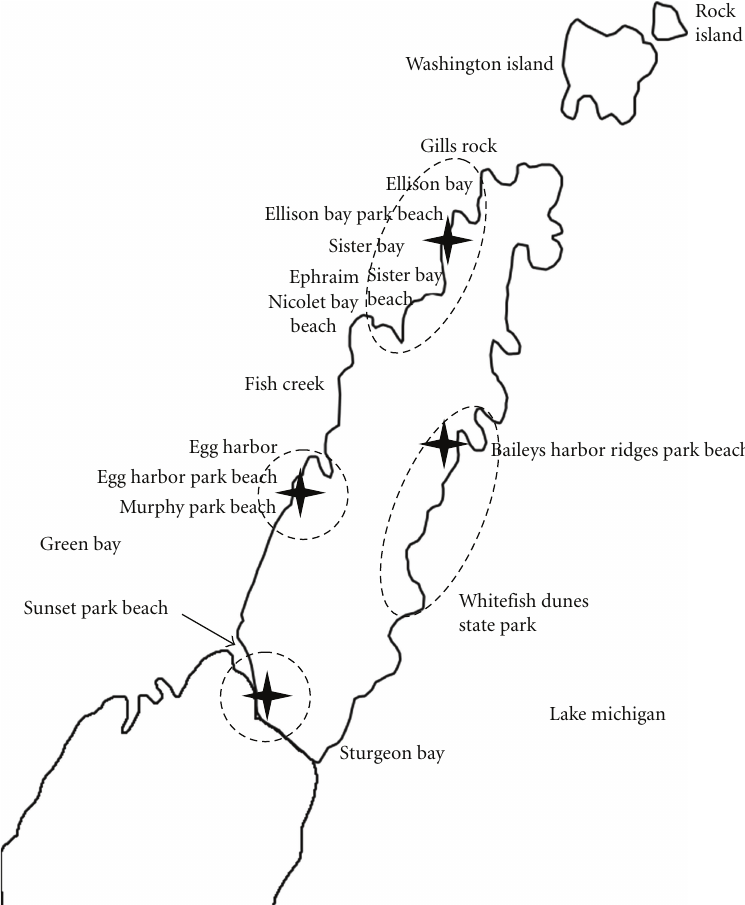
Figure 1: Beaches utilized in this study were located along the Lake Michigan and Green Bay coastlines in Door County, Wisconsin. Stars indicate location of the rain gauges and the dashed lines show the beaches that were studied based on the rainfall at those locations.